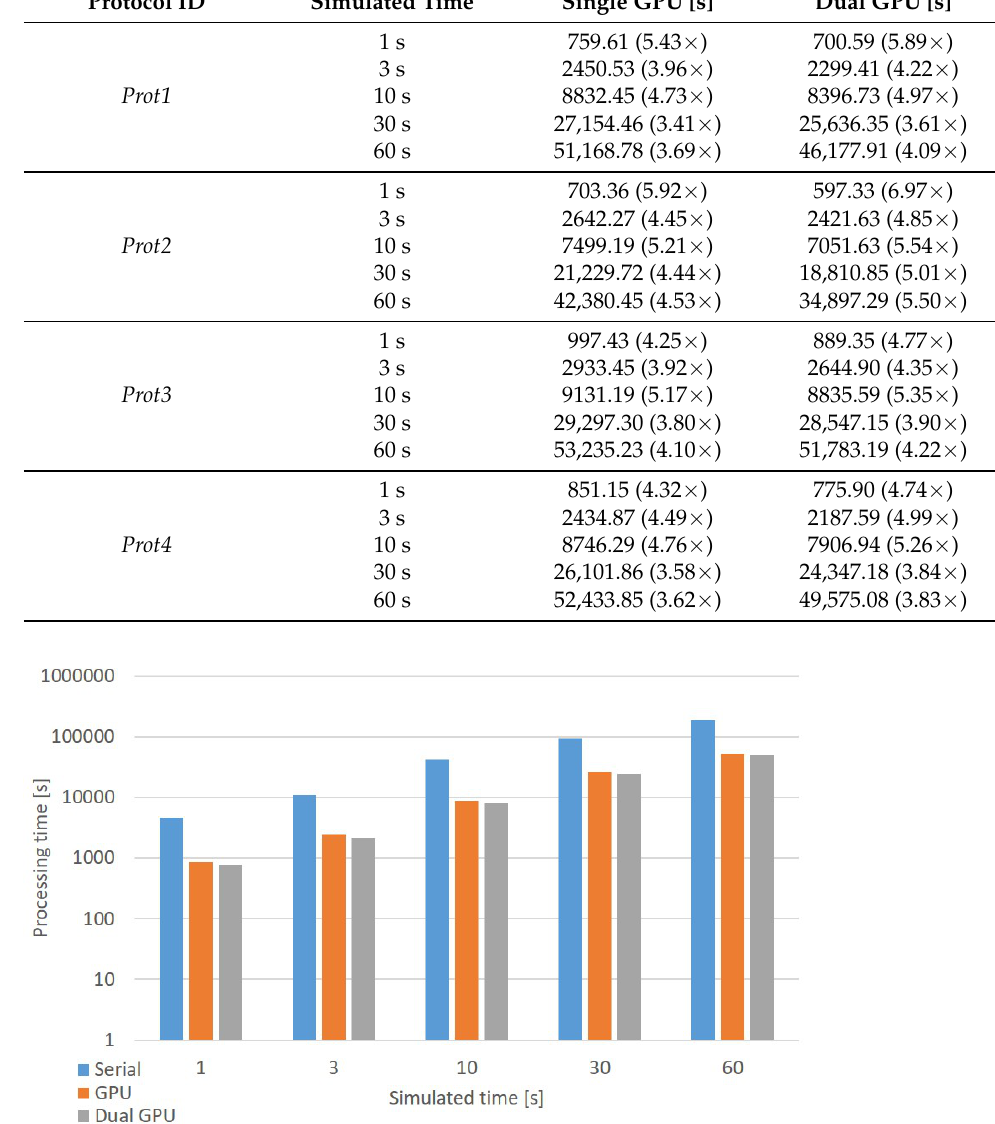
Figure 6. Chart of the processing time of the Network3 when stimulated with Prot4 . The processing time is represented in logarithmic